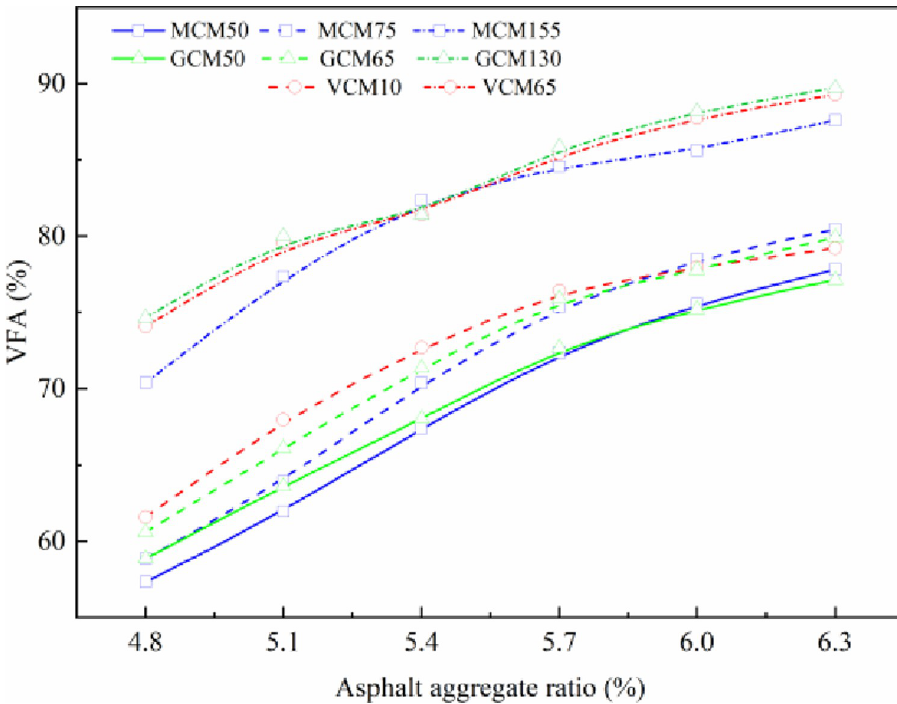
Fig 6. The relationship curve between VFA and asphalt aggregate